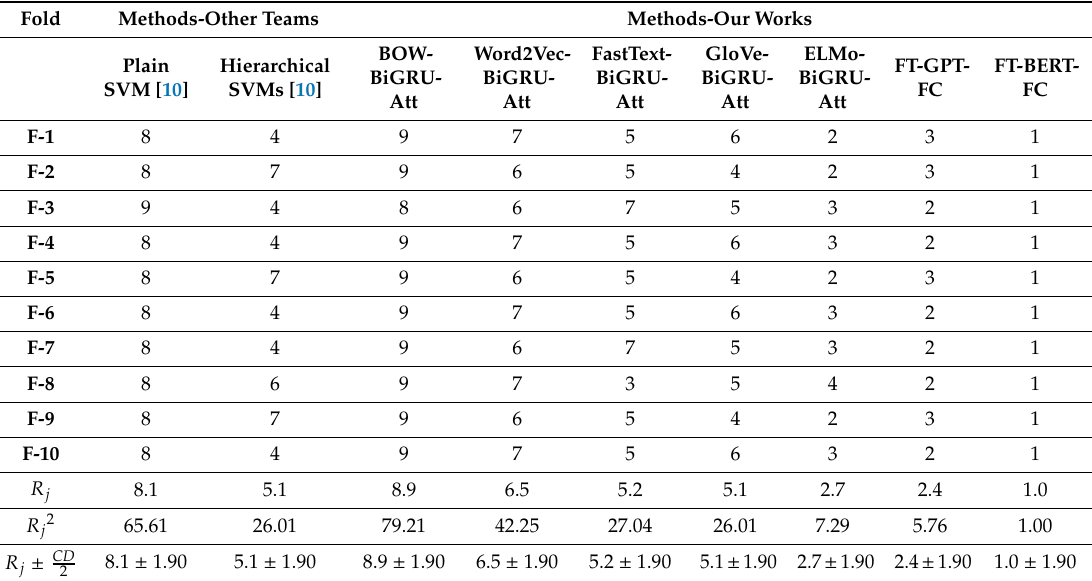
Table 6. The 10-fold cross-validation rank of Micro- F 1